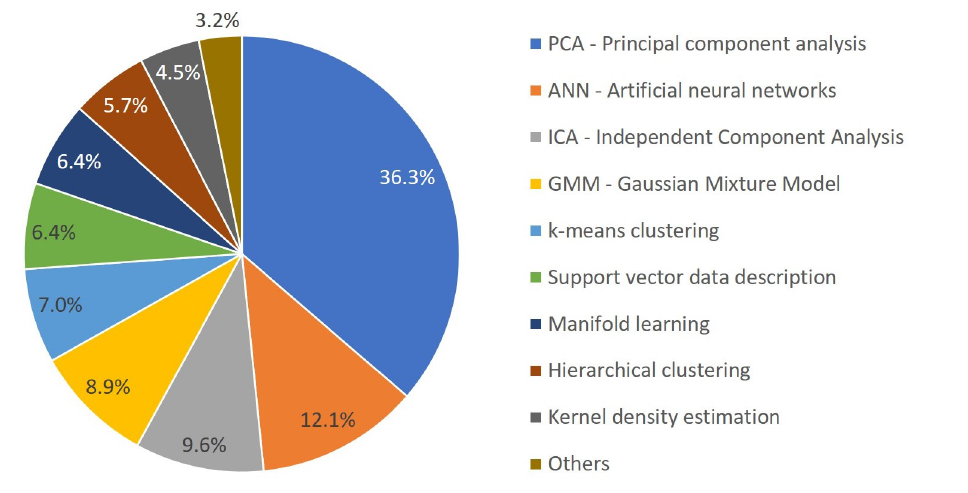
Figure 4. Distribution of unsupervised learning methods in the reviewed CPE applications.